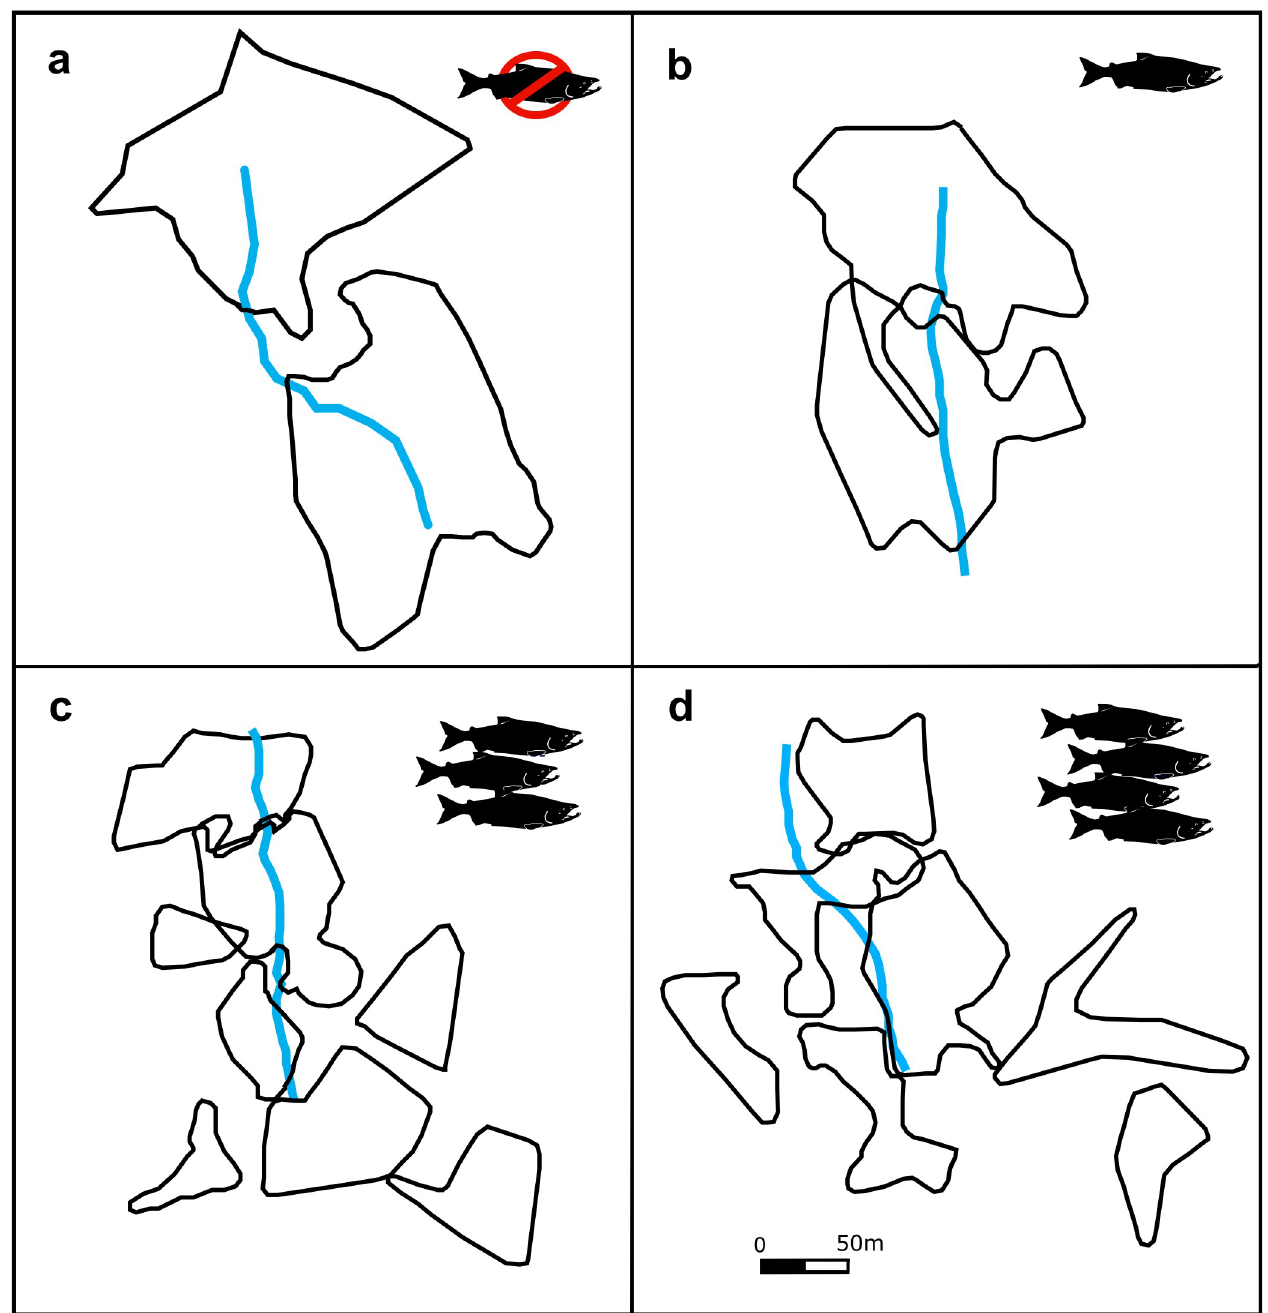
Fig 1. Representation of the territories of male Pacific wrens at different streams with different numbers of spawning salmon (A-D). Each polygon represents an individual wren territory along a stream: (a) Ripley with no salmon, (b) Fancy Right with ~2,500 kg, (c) Fannie Left with 32,000 kg, and (d) Clatse with 47,000 kg average annual spawning pink and chum salmon biomass. Blue lines represent the respective streams and the salmon drawing represents amount of salmon biomass. https://doi.org/10.1371/journal.pone.0254314.g001 fewer than three survey visits or that had fewer than three total observations throughout the breeding season were excluded from the analysis as we categorized them as floaters unable to establish a breeding territory.